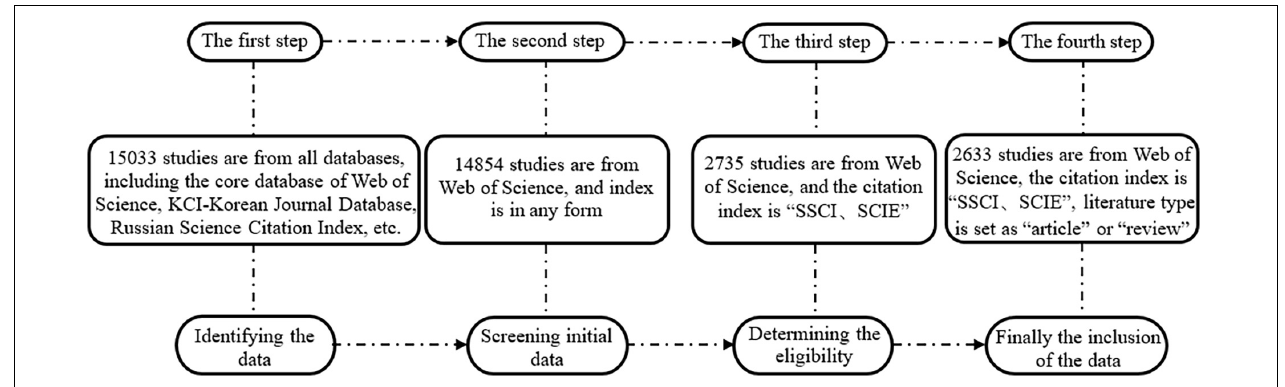
FIGURE 1 | Identification process for relevant